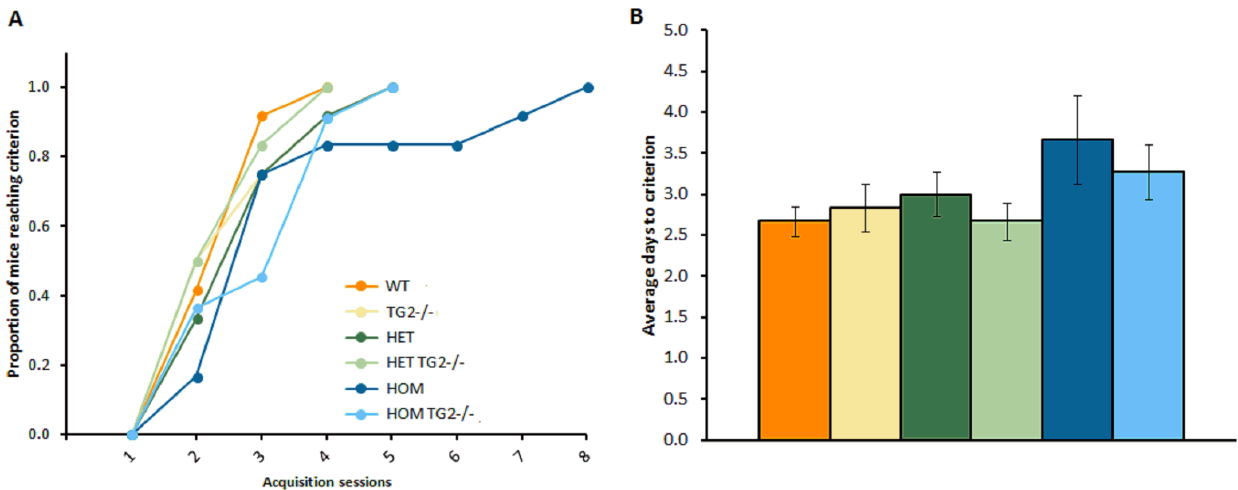
Figure 7. Acquisition of the procedural T-maze task in the zQ175 6 TG2 KO animals (n=11–12, per genotype). A. Proportion of mice acquiring the task on each test day. B. Average ( 6 SEM) number of days to acquire the task. WT: wild-type, TG2 + / 2 : heterozygous TG2 knockout, TG2 2 / 2 : homozygous TG2 knockout, HET: zQ175 HET, HOM: zQ175 HOM.